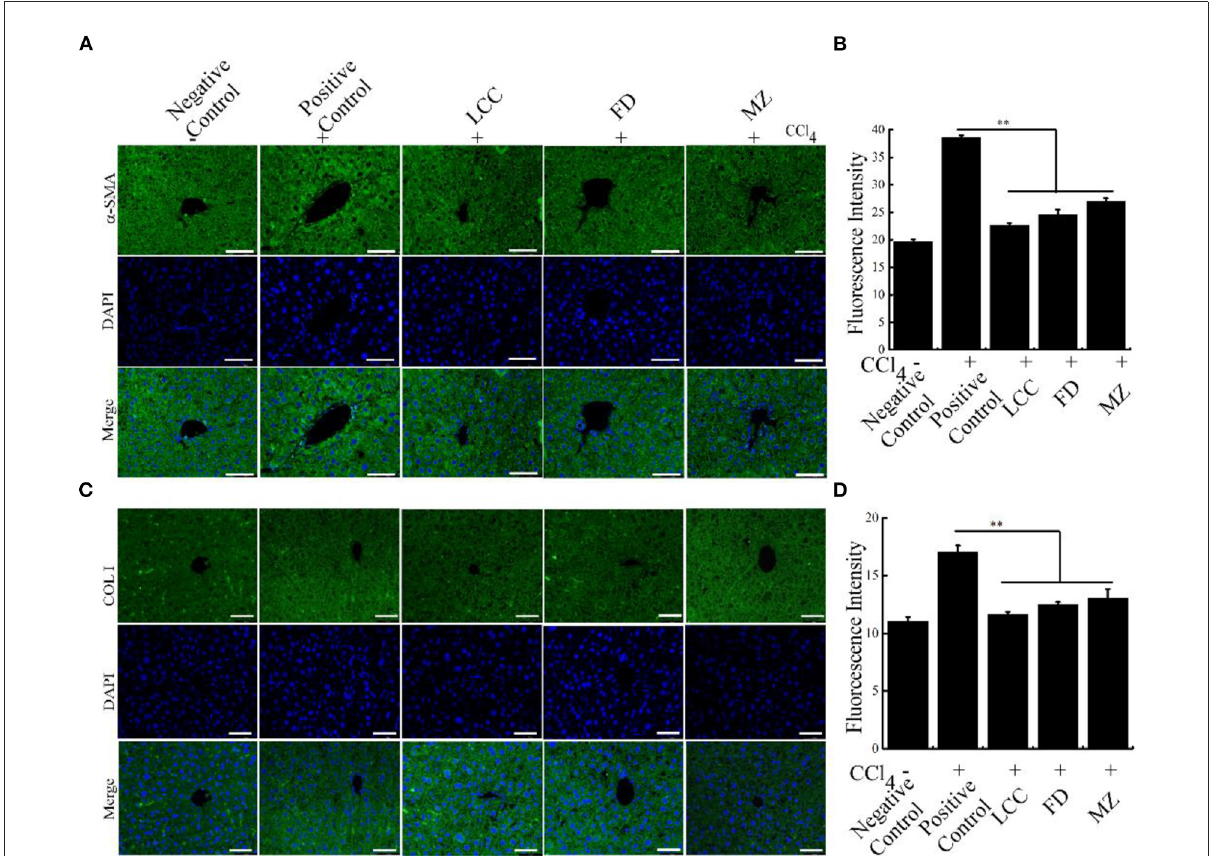
FIGURE6 The effects of TEVs on the expression of fibrotic markers in mice. (A) Immunofluorescence detection α -SMA protein in the different experimental groups. Scale bar = 50 µ m. (B) The relative fluorescence intensity in (A) was quantified using Image J software. (C) Immunofluorescence detection COL I protein in the different experimental groups. Scale bar = 50 µ m. (D) The relative fluorescence intensity in (C) was quantified using Image J software. Error bar represents SD ( n = 3; * P < 0.05, ** P < 0.01, indicating significantly different from positive control